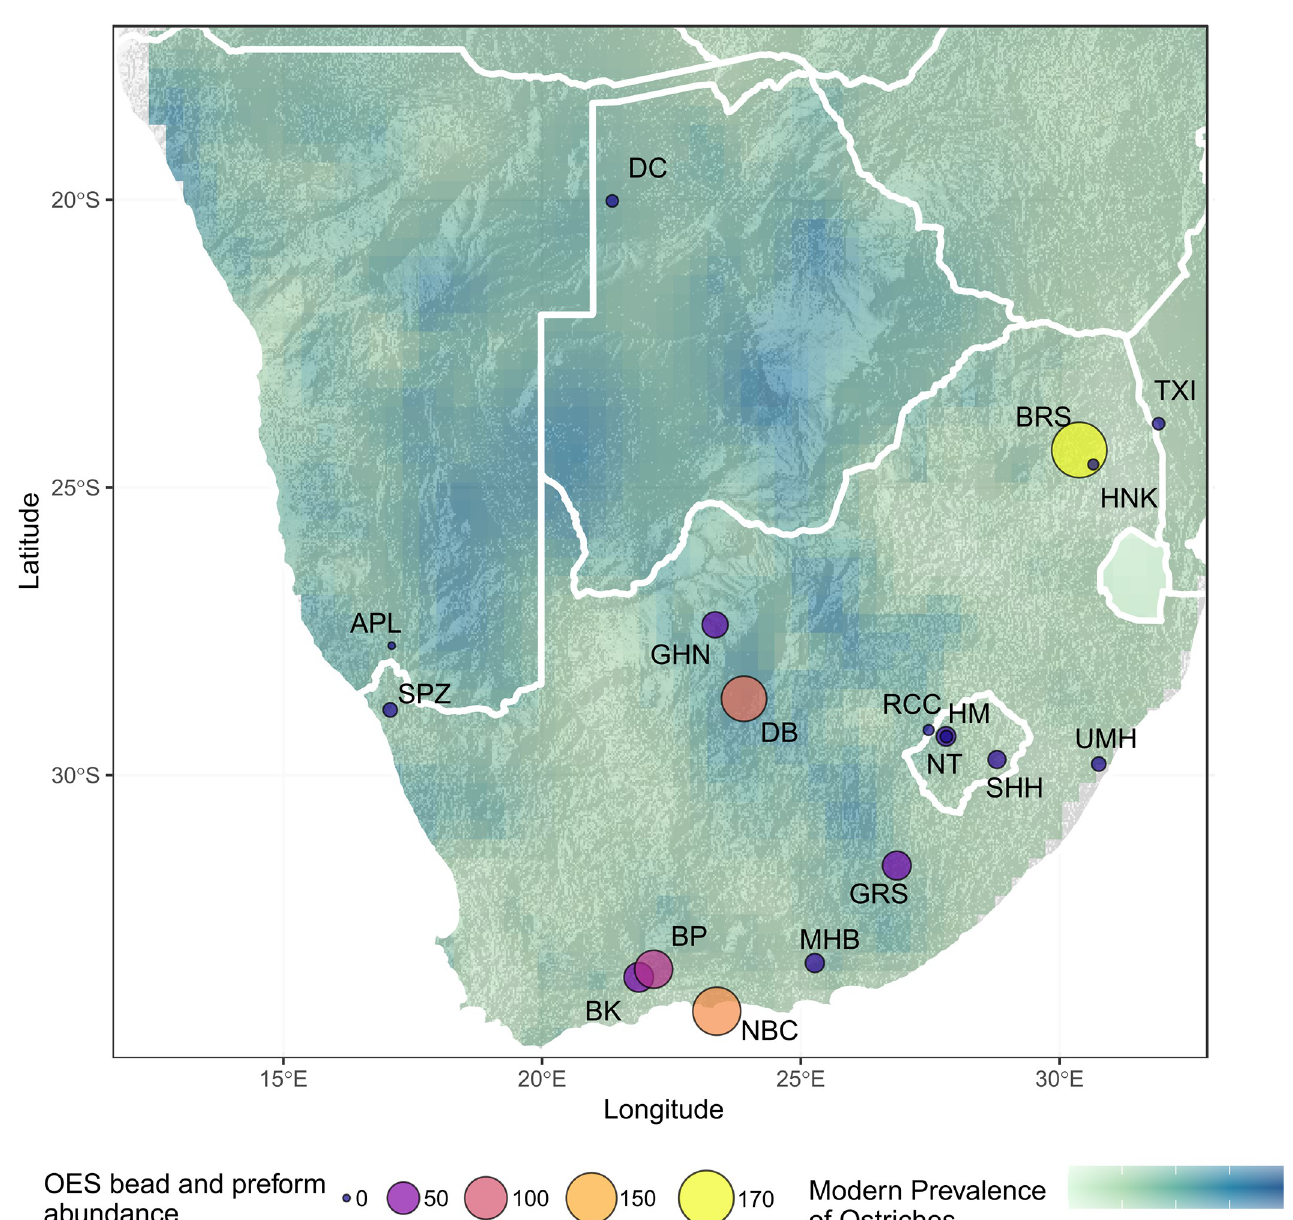
Fig 6. Map of southern Africa showing archaeological sites dated to MIS 2 that have OES bead assemblages. OES bead counts for sites, overlaid on a map of modern ostrich prevalence based on South African Bird Atlas Project 2 data [60]. BK–Buffelskloof, BP–Boomplaas, NBC–Nelson Bay Cave, MHB- Melkhoutboom, GRS—Grassridge Rockshelter, NT–Ntloana Tsoana, RCC–Rose Cottage Cave, HM—Ha Makotoko, SHH–Sehonghong, UMH–Umhlatuzana, BRS–Bushmans Rockshelter, HNK—Heuningneskrans, TXI—Txina Txina, GHN–Ga-Mohana Hill North, DB—Dikbosch, DC—Drotsky’s Cave (Gcwihaba Cave), APL—Apollo 11,